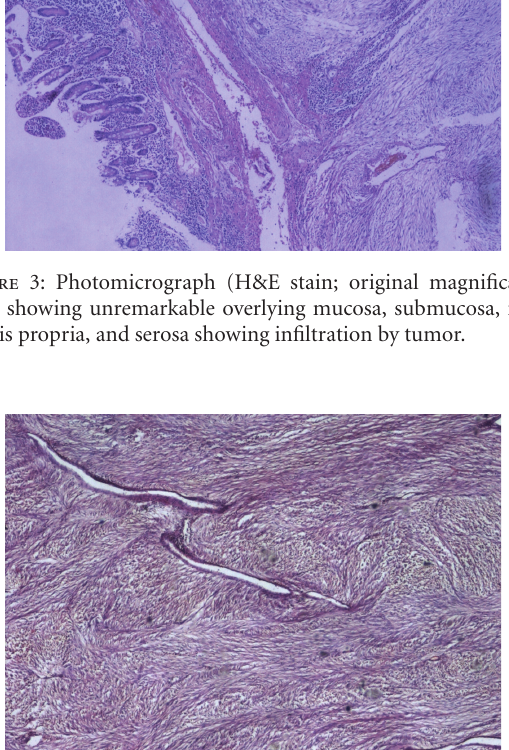
once daily was given as adjuvant chemotherapy, and patient is asymptomatic without any evidence of tumor recurrence after six months of postoperative